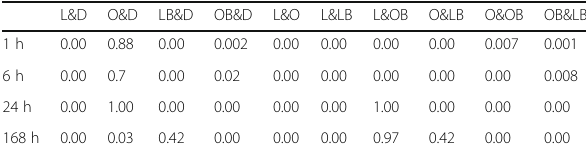
Table 5 Release of nickel ions from SS wires at various time-points